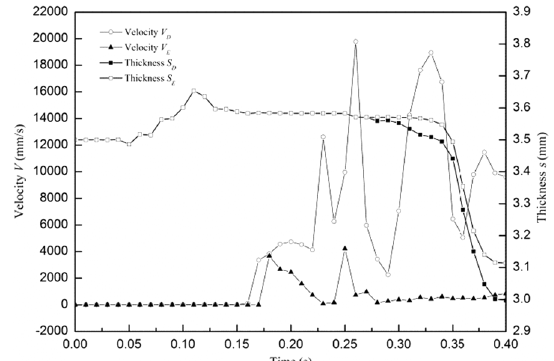
Figure 36 Curves of fluid velocity and wall thickness at points D and